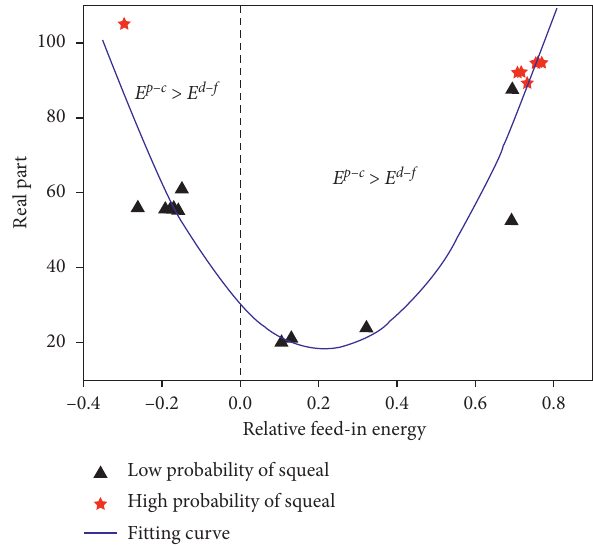
Figure 9: Relationship between the complex real part and the relative feed-in